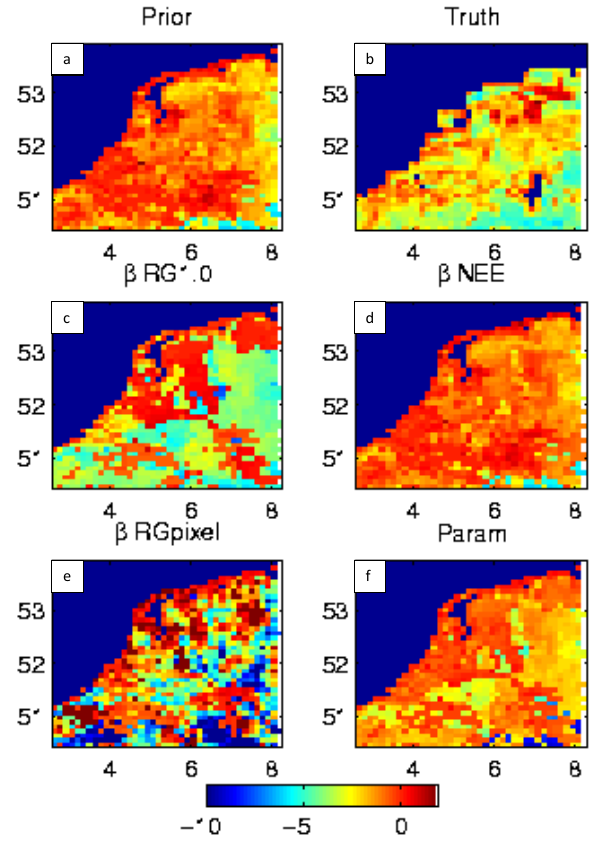
Fig. 2. The spatial distribution of the two-week average fluxes: top left: prior (from 5PM model); top right: “true” flux (from FACEM model); the other pictures show the averaged posterior estimates of the different inversion methods. Both sets of fluxes are used with hourly temporal